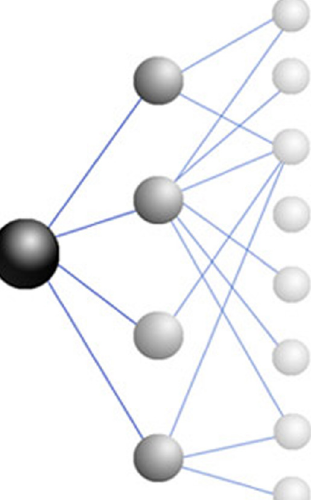
Figure 1. Identifying new relationships that are potentially implicit from known relationships. IRIDESCENT’s method of analysis begins with a primary object of interest such as T2DM (black node) and then identifies all co-citations with other ob- jects (gray nodes) observed within Medline. IRIDESCENT then examines all these directly related (gray) nodes in turn for their relationships with other objects (white nodes) that are not them- selves related to the primary object. Once all of Medline is an- alyzed and all implicit relationships (white nodes) are identi- fied, all relationships they share (gray nodes) with the primary node are individually scored for their statistical significance of co-occurrence and collectively scored for statistical significance against a random network